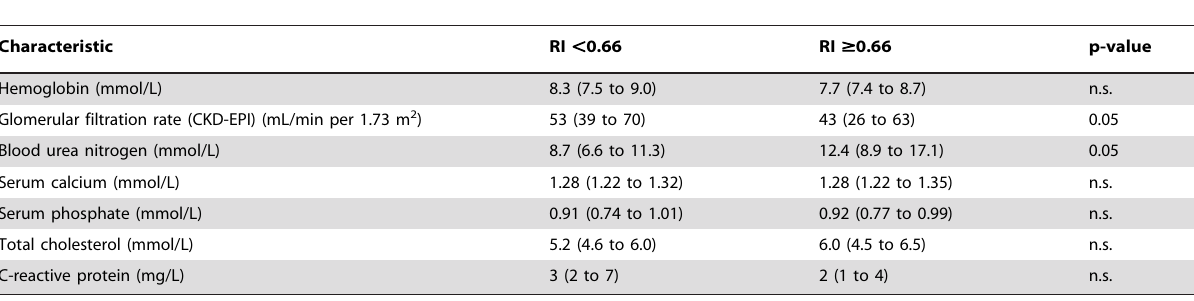
Table 2. Biochemical characteristics of patients with renal allograft.